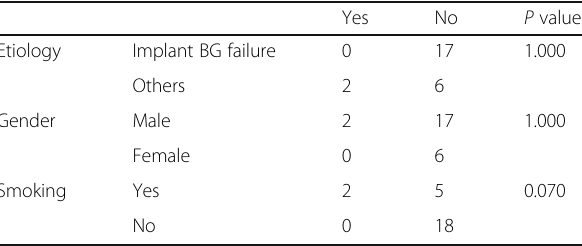
Table 2 Association between risk factors and postoperative